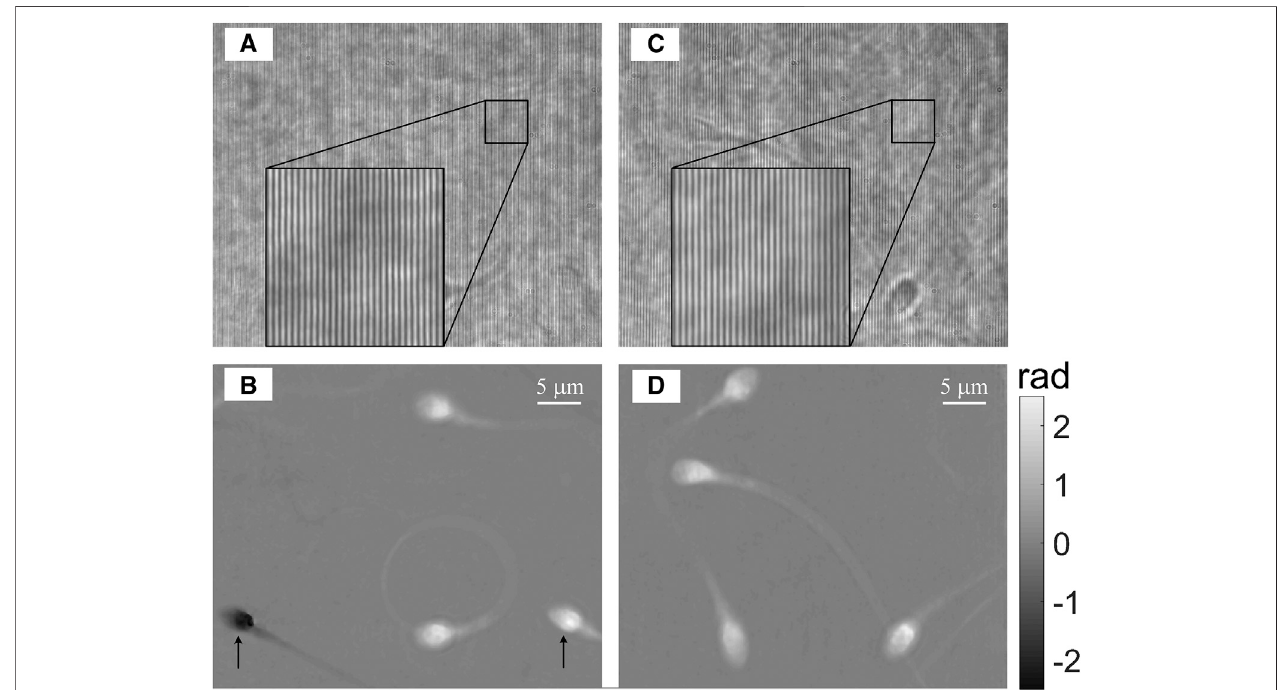
FIGURE4| Dynamicquantitativephaseimagingofhumanspermcellsswimmingin80%PureCeptionmedium. (A,B) Off-axishologram (A) andquantitativephase pro fi le (B) with a small lateral shearing distance, as acquired by the LC-SICA module. See dynamic quantitative phase pro fi le in Supplementary Video S1 . (C, D ) Off- axis hologram (C) and quantitative phase pro fi le (D) with a large lateral shearing distance, acquired by the LC-SICA module. See dynamic quantitative phase pro fi le in SupplementaryVideoS2 .Theblackarrowsin (B) indicatetwoconjugateimagesofthesamecell:oneimagehaspositivephasevalueswhiletheotherimagehas negative values (ghost image), which might overlap with the positive-value cells, as demonstrated in Supplementary Video S1 . This unwanted effect can be avoided if the shearing distance is fully controlled without direct relation to the off-axis angle. This off-axis angle is chosen to be optimal and constant, as can be seen in both holograms (A) and (C) , both having the same spatial frequency of the interference fringes, in spite of the fact that the shearing distance is different.